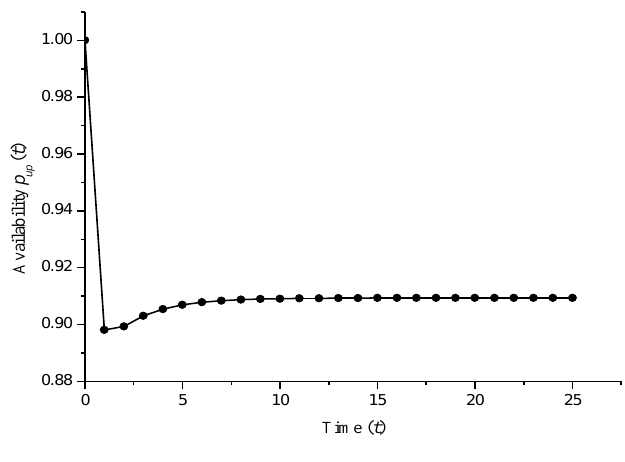
Figure 3. Availability of the system with copula.